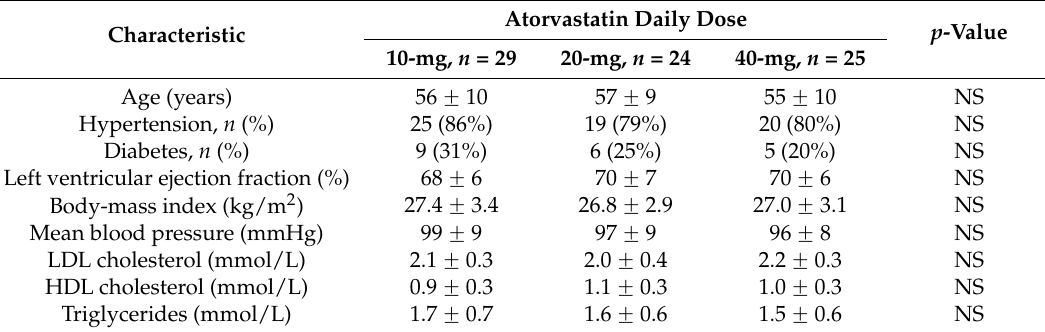
Table 1. Patients’ characteristics according to atorvastatin